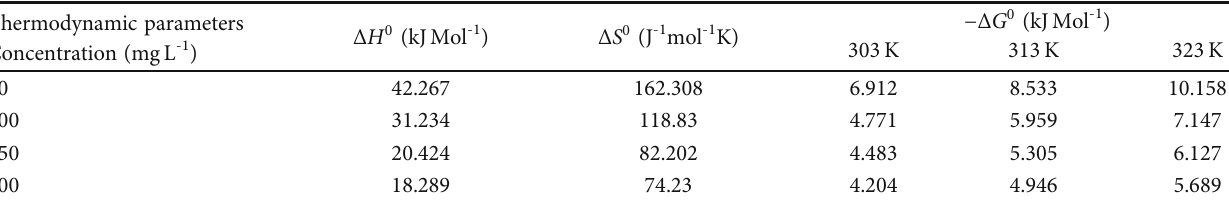
Figure 19: Data kinetics fi t of Dumwald-Wagner model with CV concentrations of (a) 50ppm, (b) 100ppm, and (c) 200ppm. Table 10: Calculated thermodynamic